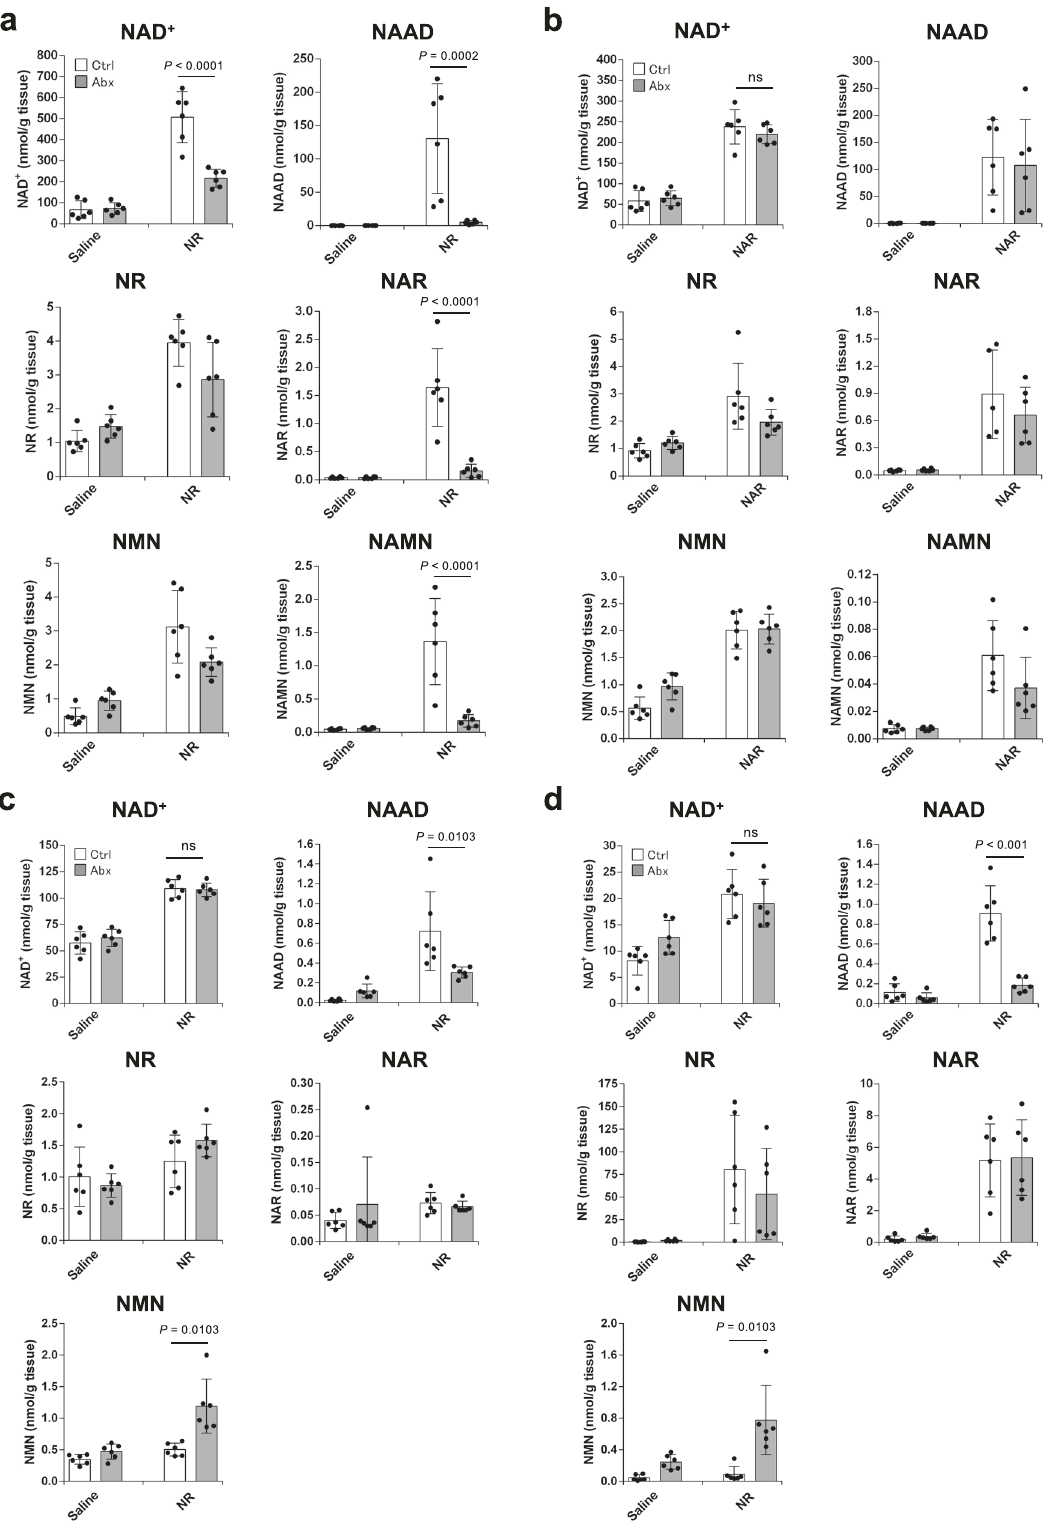
Fig. 2 Gut microbiota is important for NAD + increase in the late phase after NR administration. Wild-type mice were treated with either regular water (Ctrl) or antibiotic-containing water (Abx) for 3 days to deplete gut microbiota. They were then gavaged with 400 mg/kg NR or equivalent molar amount of NAR, and killed after 30 min or 3 h. a , b Concentrations of NAD + metabolome in the liver were measured by LC-MS 3 h after the gavage of NR ( a ) ( n = 6 mice per group) and NAR ( b ) ( n = 6 mice per group). c , d Concentrations of NAD metabolome in the liver ( c ) ( n = 6 mice per group) and small intestine ( d ) ( n = 6 mice per group) were measured by LC/MS 30 min after the gavage of NR. Data are shown as mean ± S.D. ns not signi fi cant. Statistical signi fi cance was determined by one-way ANOVA followed by Tukey ’ s post-hoc tests. Source data are provided as a Source Data fi